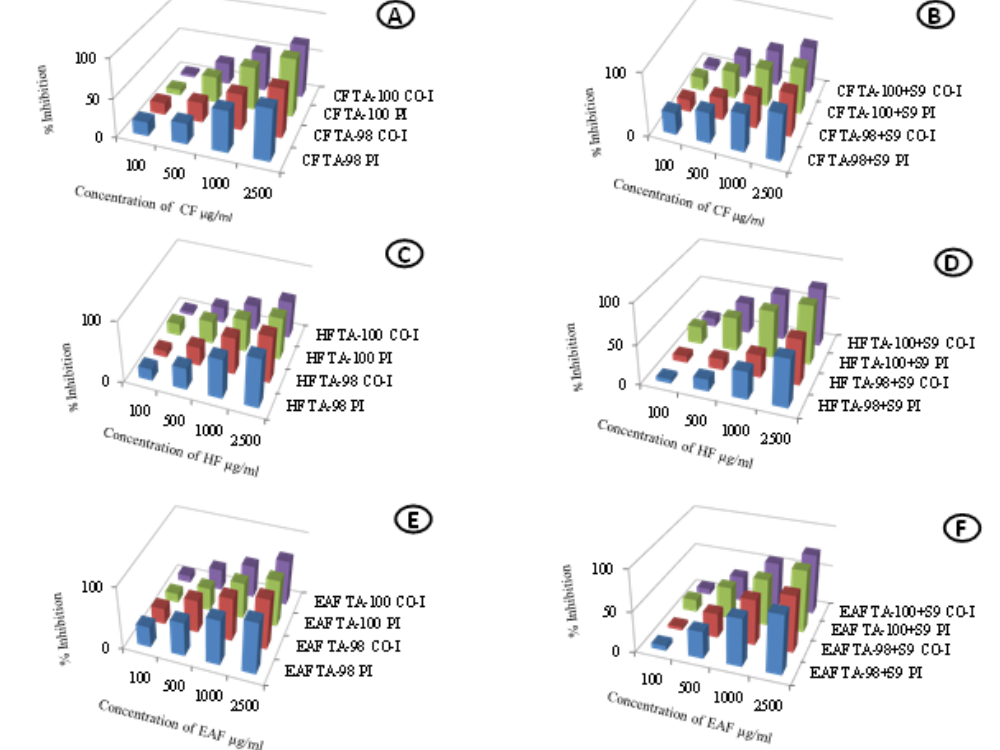
Figure 3. Antimutagenic activity of Rhododendron arboreum fractions in TA-98 and TA-100 strains of Salmonella typhimurium. Pre-incubation (PI) and co-incubation (Co-I) modes of experimentation; without metabolic activation against direct acting mutagens, 4-nitro- O -phenylenediamine for TA-98 & sodium azide for TA-100 and with metabolic activation against 2-aminofluorene using rat liver homogenate (S9). ( A ) Chloroform fraction (CF) without metabolic activation; ( B ) Chloroform fraction (CF) with metabolic activation; ( C ) Hexane fraction (HF) without metabolic activation; ( D ) Hexane fraction (HF) with metabolic activation; ( E ) Ethyl acetate fraction (EAF) without metabolic activation; ( F ) Ethyl acetate fraction (EAF) with metabolic activation.